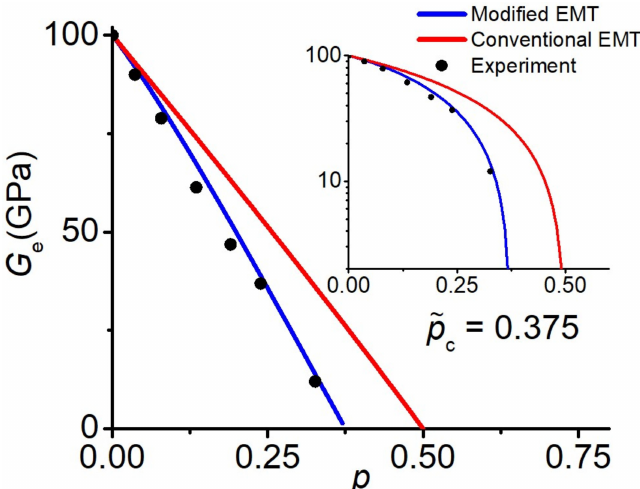
Figure 8. Porosity dependence of the e ff ective shear modulus for porous Th 2 O (powder size 0–2 µ m). Experimental values are taken from [57]. The inset shows the same data on the logarithmic